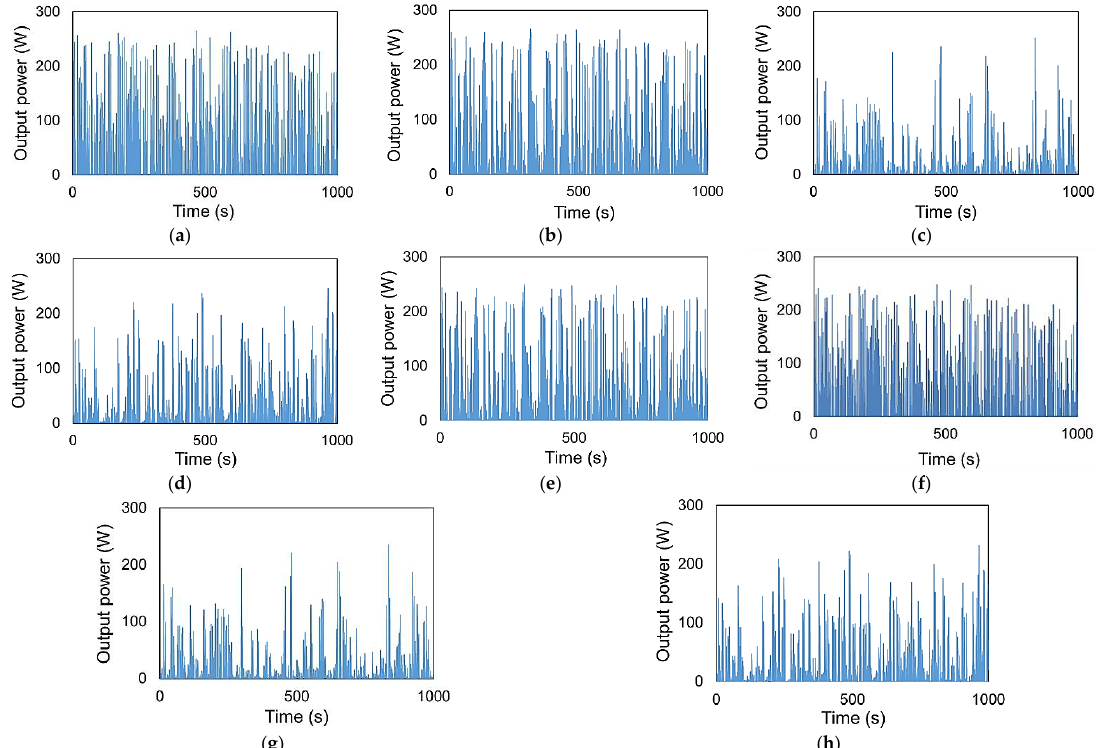
Figure 22. Output power graphs of iron-cored LPMG under random wave with ( a ) 1.5 m significant wave height; ( b ) 4.5 m significant wave height; ( c ) 0.83 Hz peak frequency; ( d ) 0.61 Hz peak frequency, and of semi iron-cored LPMG under random wave with ( e ) 1.5 m significant wave height; ( f ) 4.5 m significant wave height; ( g ) 0.83 Hz peak frequency; ( h ) 0.61 Hz peak frequency.